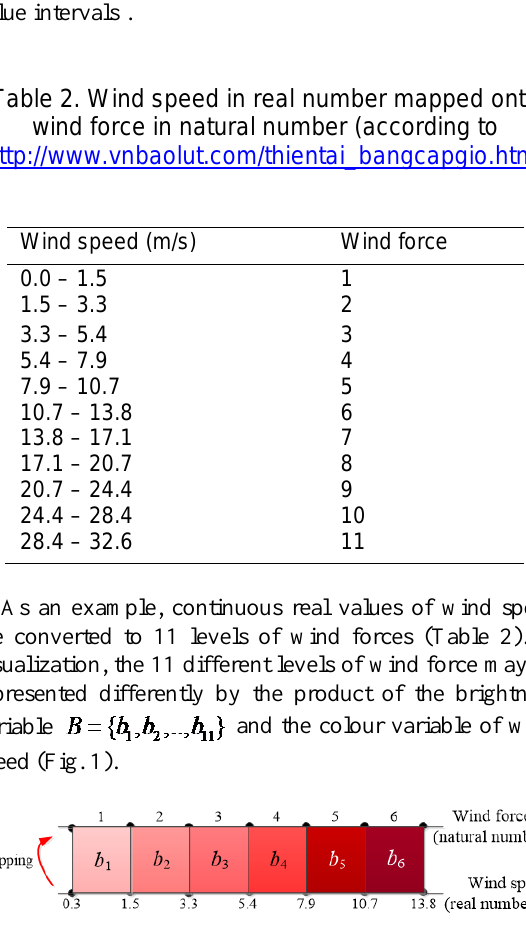
Figure 1. The product of brightness variable and Figure 3. Multivariate cube modified from parallel colour variable to represent different levels of wind coordinates force. Multivariate cube is modified from parallel coordinates, where the common-used reference axis is rotated to the direction perpendicular to the plane of parallel coordinates [11, 12] (Fig. 3). In multivariate cube, each data variable is represented as an axis and referred to common-used reference axis perpendicular to the axis ., where the common-used reference axis represents the variable on which all other variables depend. Multivariate cube enables user to answer elementary questions by viewing marks representing data values on graphs, to understand the variation of each data variable on the whole reference axis, and to cognize the correlation among data variables by viewing marks representing data values on the planes parallel with the plane of parallel coordinates and moved along to the common-used reference